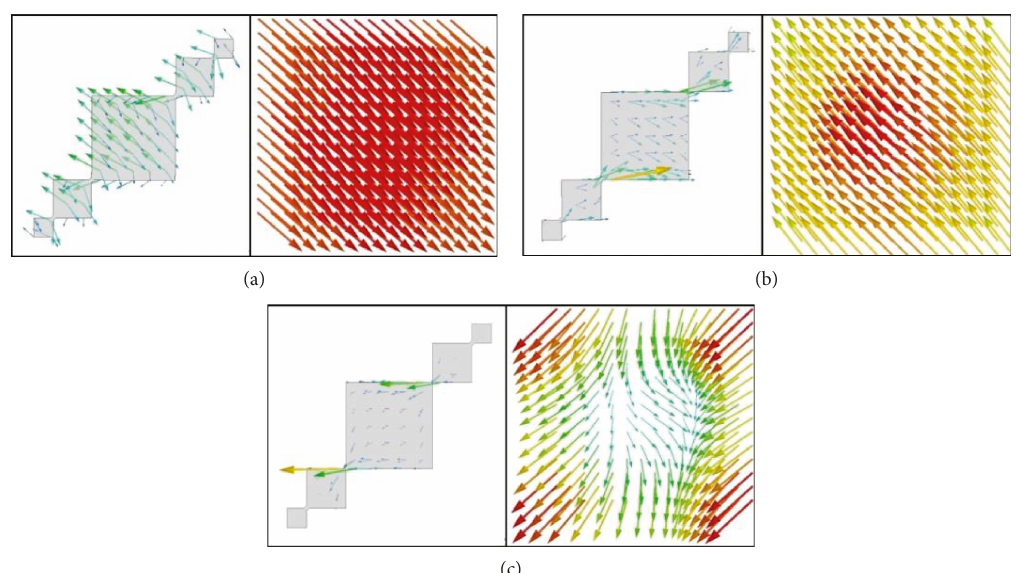
Figure 5: Current distribution on the QFS and ground plane at the resonant frequency points: (a) 11.1 GHz; (b) 22.2 GHz; (c) 32.6GHz.